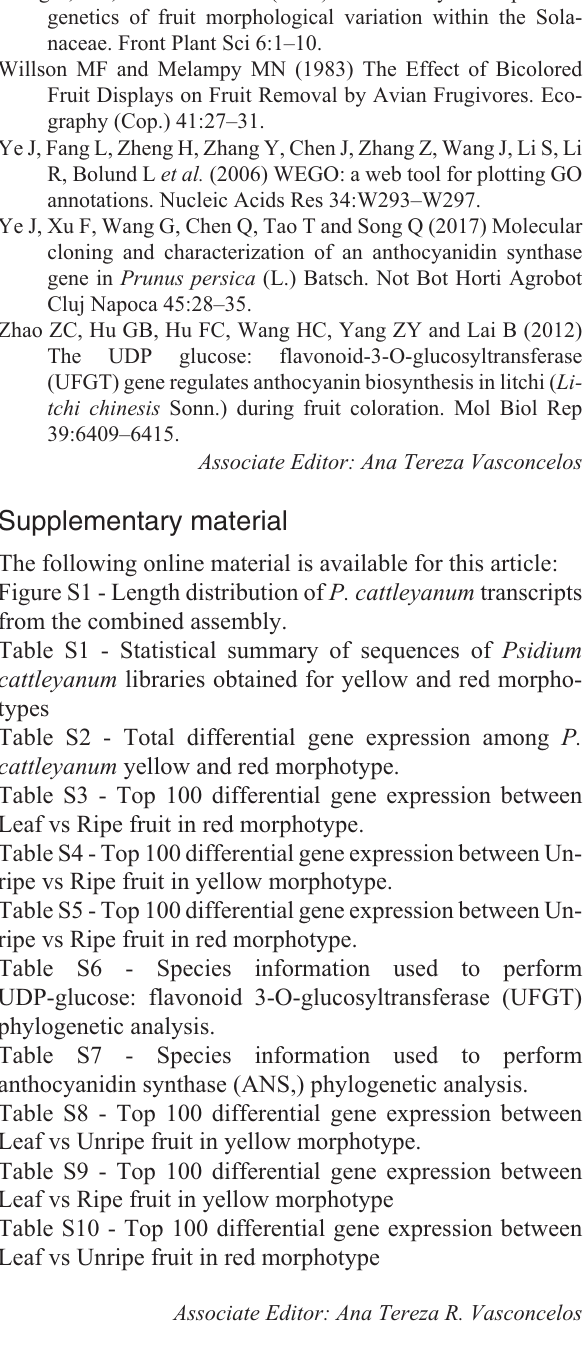
Table S7 - Species information used to perform Table S8 - Top 100 differential gene expression between Leaf vs Unripe fruit in yellow morphotype. Table S9 - Top 100 differential gene expression between Leaf vs Ripe fruit in yellow morphotype Table S10 - Top 100 differential gene expression between Leaf vs Unripe fruit in red